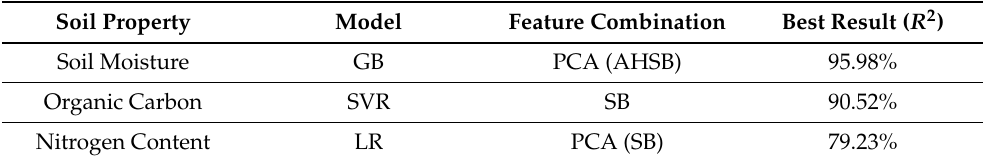
Table 5. Best prediction results with specific feature combinations and machine learning regres- sor